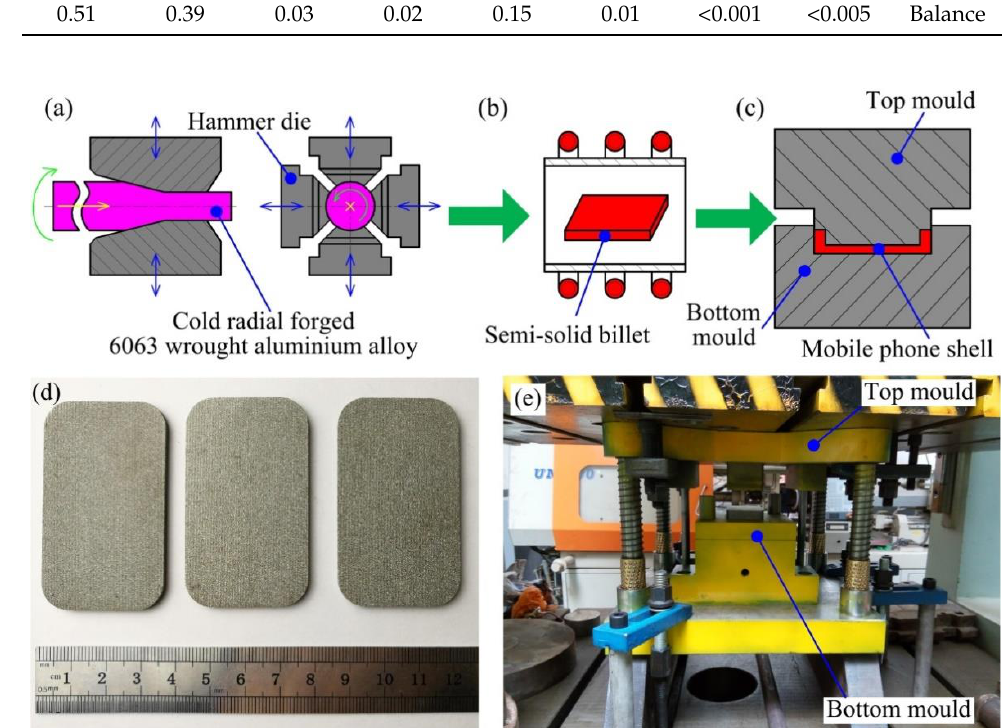
Figure 1. Schematic illustration of the semi-solid thixotropic extrusion forming process for the mobile phone shell: ( a ) Step A—deformation, ( b ) Step B—SSIT, ( c ) Step C—forming, ( d ) Picture of the forming samples, and ( e ) Picture of the forming